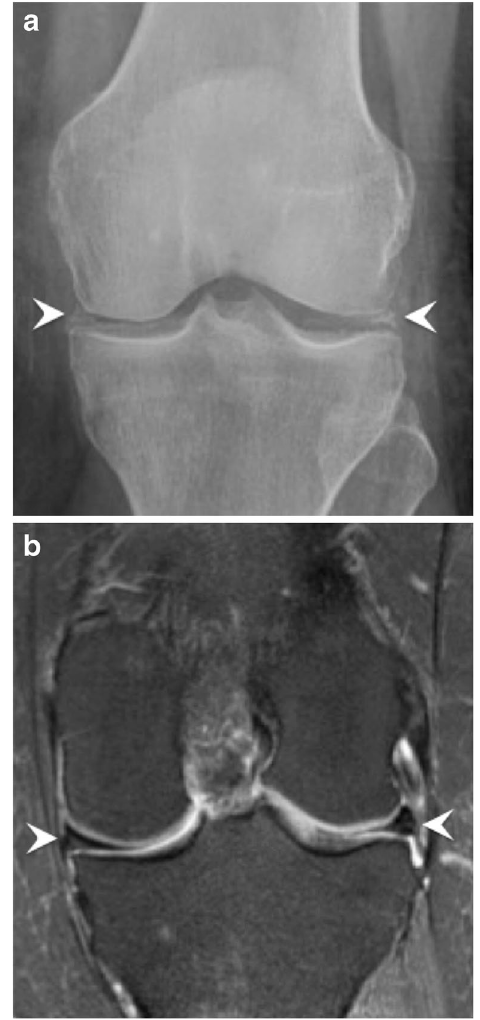
Fig. 11 Chondrocalcinosis in the knee. ( a ) Anteroposterior radiograph of the left knee and ( b ) coronal fat-saturated proton density (PD)-weighted MRI image show chondrocalcinosis in the menisci (arrowheads)